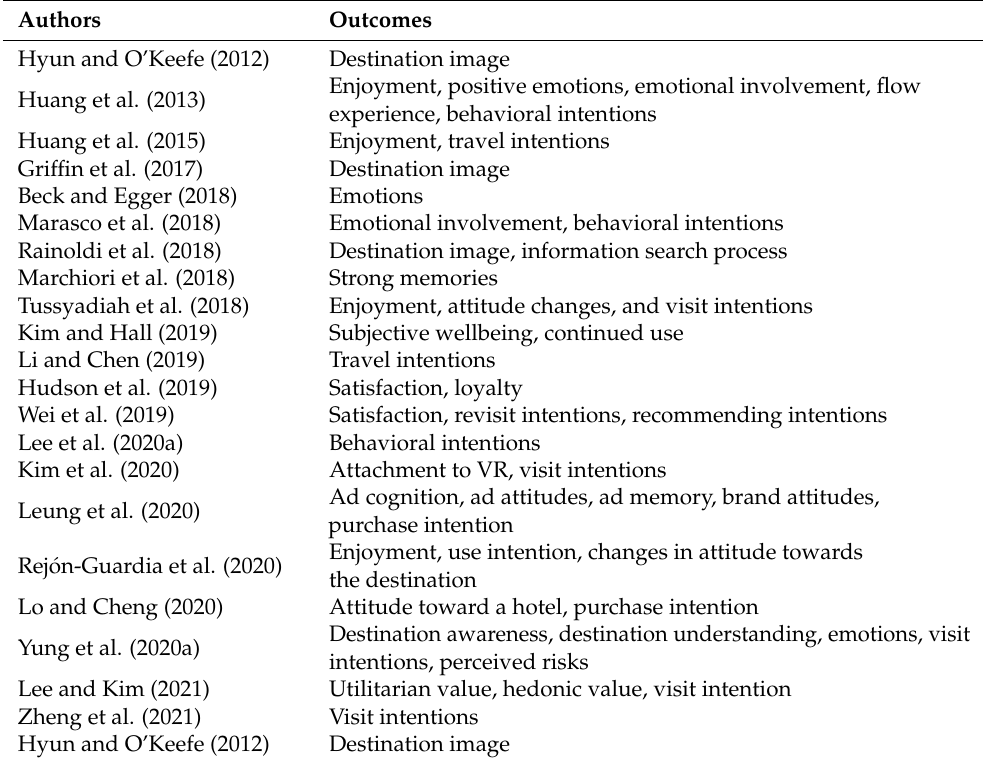
Table 2. Outcomes of virtual